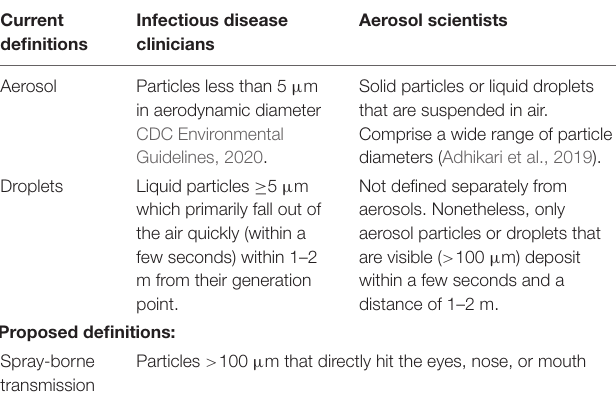
TABLE 1 | Current and proposed